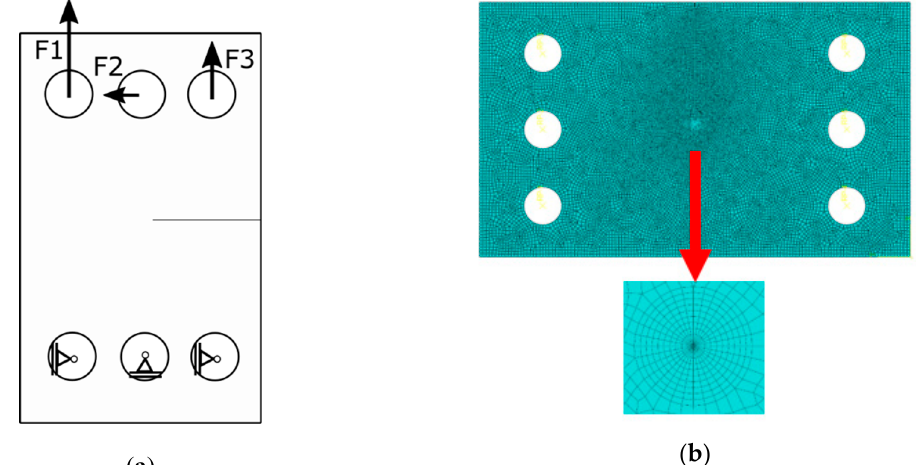
Figure 6. CTS specimen numerical analysis: ( a ) Boundary conditions; ( b ) finite element mesh with detail overview near the crack tip.